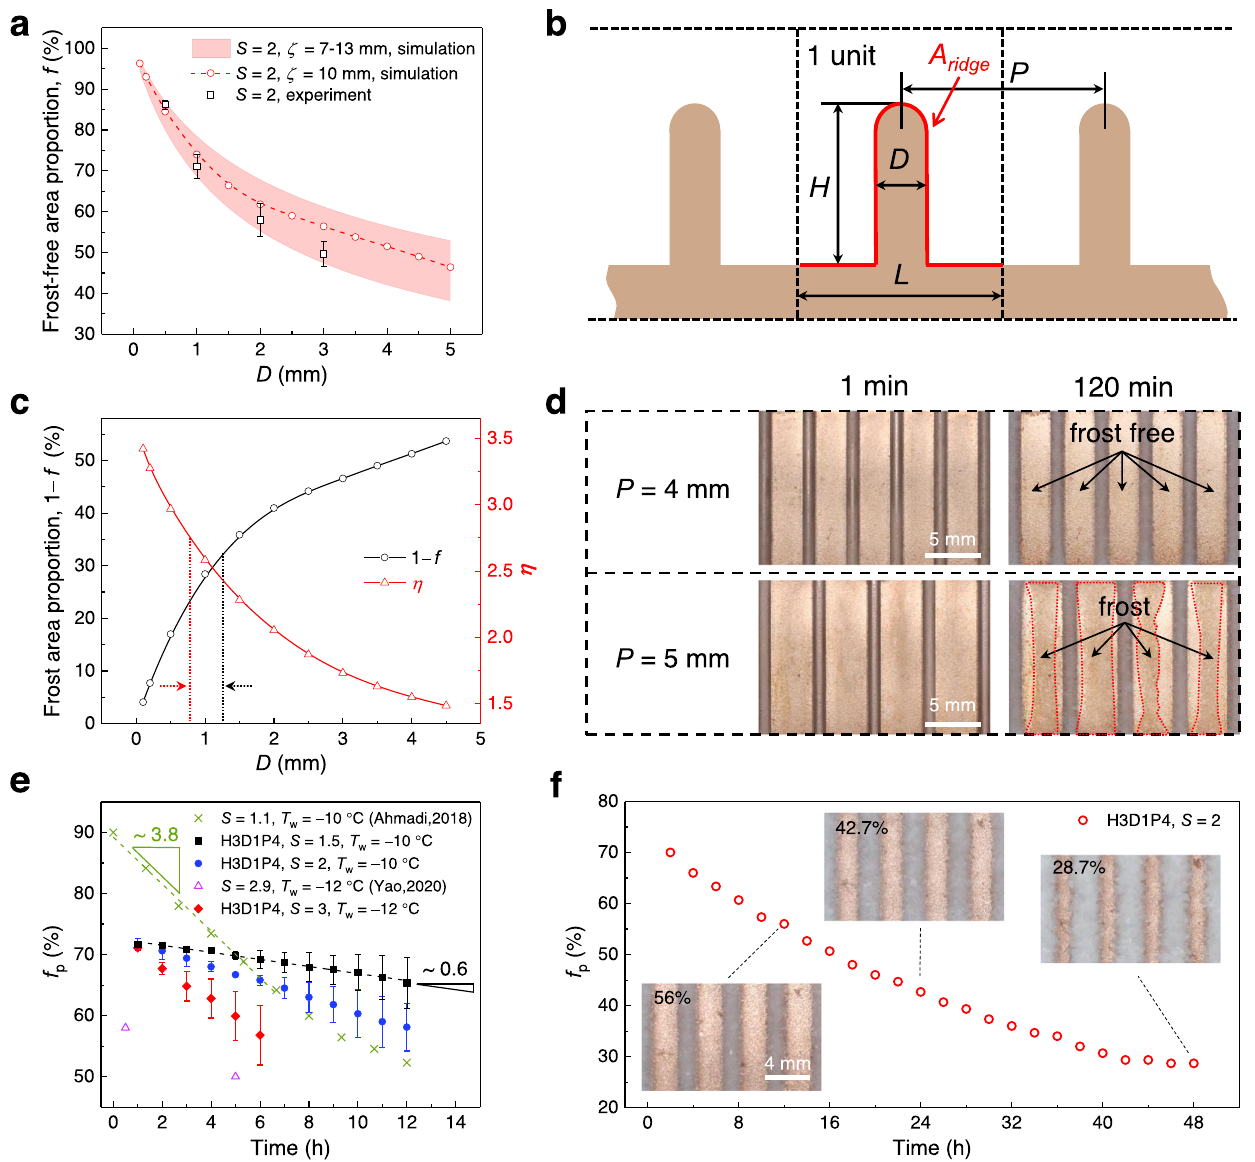
Fig. 4 Frosting on the macro-ridge arrayed surface. a Frost-free area proportion as a function of ridge width D on the surface with single ridge. The pink band represents the simulated results using the boundary layer thickness ranging from 7 mm to 13 mm. The experimental f are obtained at one hour after the experiment begins (Supplementary Fig. S14), and all results are repeated for three times. b Schematic showing the structure parameters of the macro- ridged array surface. c In fl uence of frost area proportion (1 − f ) and dimensionless surface area ( η ) changed with the ridge width D . d Experimental results on the macro-ridge arrayed surface with P = 4 mm and 5 mm, respectively, under S = 2 and T w = − 7 ∘ C. e Experimental results on the macro-ridge arrayed under S = 2 and T w = − 10 ∘ C for 48 h. The error bars denote the standard deviation from three